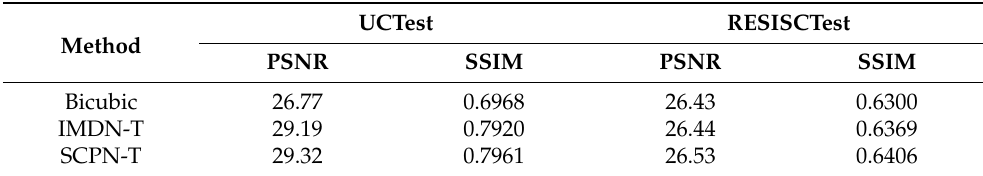
Table 3. Quantitative results of the compared methods for scale factor × 4. Bold numbers indicate the best performance. The suffix T denotes that the parameters in the model are after tuning.